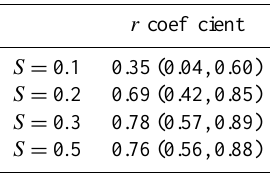
Table 5. Correlation coefficients between 24h averages of the bio- genic PMF factor and CCN number concentration at Raven’s Nest for different supersaturations ( S ). The numbers within the brackets represent 90% confidence